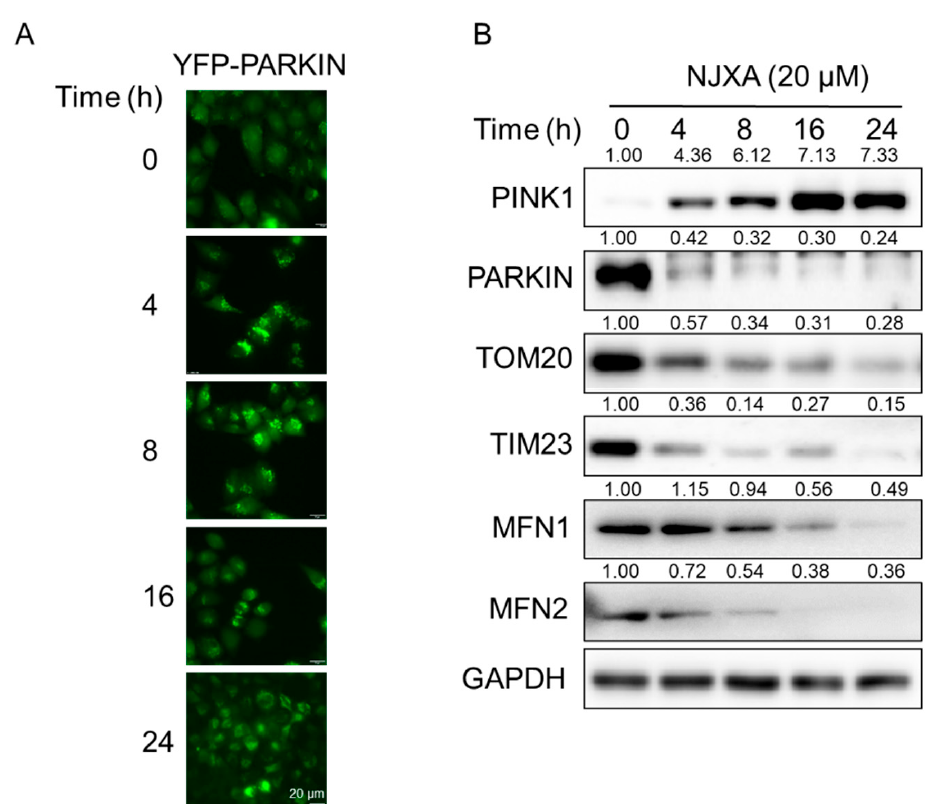
Figure 1. NJXA promotes Parkin ‐ dependent mitophagy in HeLa cells. ( A ) YFP ‐ Parkin HeLa cells were treated with NJXA (20 μ M) for 0–24 h, and the distribution of YFP ‐ Parkin was examined by immunofluorescence microscopy. Scale bar = 20 μ M. ( B ) HeLa cells treated with NJXA (20 μ M) for 0–24 h were analyzed by immunoblotting for PINK1, PARKIN, TOM20, TIM23, MFN1, and MFN2. GAPDH was served as loading control. The values above the bands indicate the relative 669 band intensities. Data are presented as the means ± SD of three independent experiments.